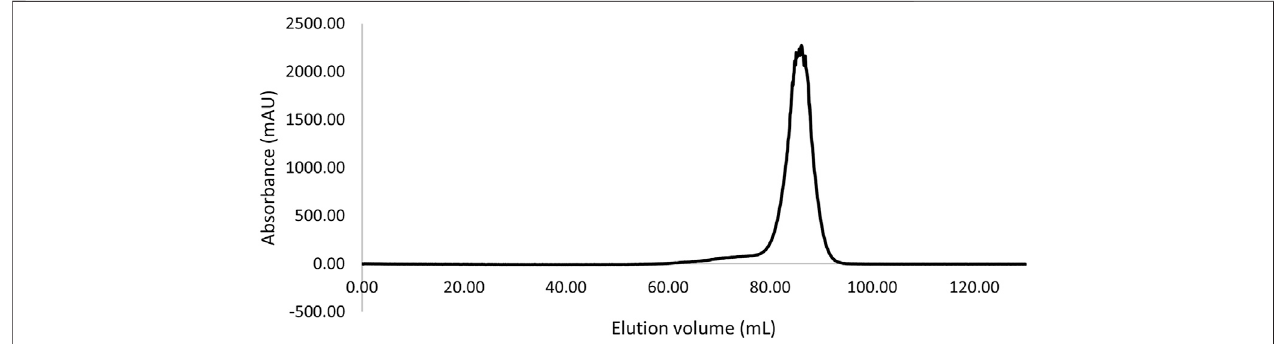
FIGURE1| Sizeexclusionchromatographyelutionpro fi le(Superdex200HiLoad16/600)oftheTsLIwithanapparentmolecularmasssuggestingadimericstateof the protein ( ∼ 46 kDa).